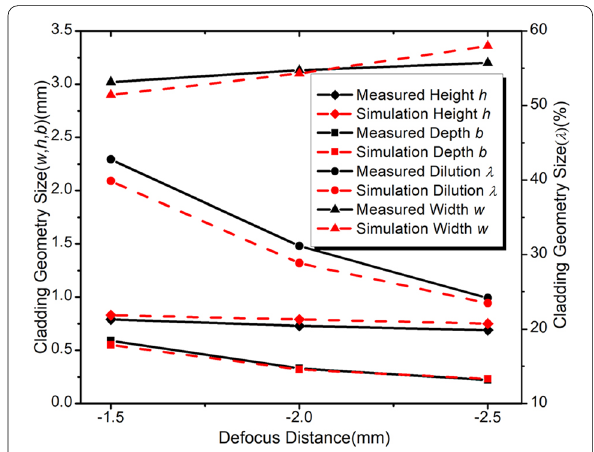
Figure 19 Comparisons between cross-sections of numerical simulation and experimental clad geometry: width, height, depth, and